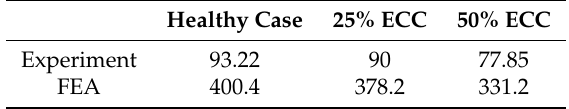
Table 1. Variation of magnitude 6th harmonic of Instantaneous Active Power (IAP) with eccentricity.